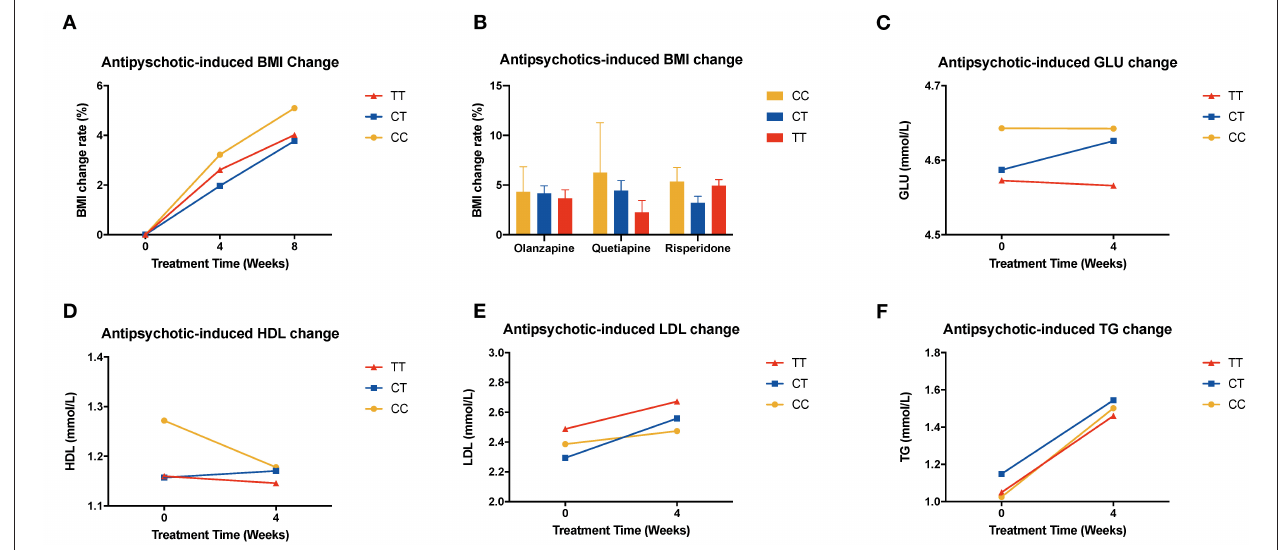
FIGURE 3 | Association of MTHFR C677T polymorphism with antipsychotic-induced BMI and metabolic index change in validation sample. (A) shows all the patients of different genotypes with increasing tendency; there is no significant difference between these three groups. (B) shows different kinds of drugs that induced BMI change rate after 8 weeks of treatment. (C–F) show the change of metabolic components of the replication samples.